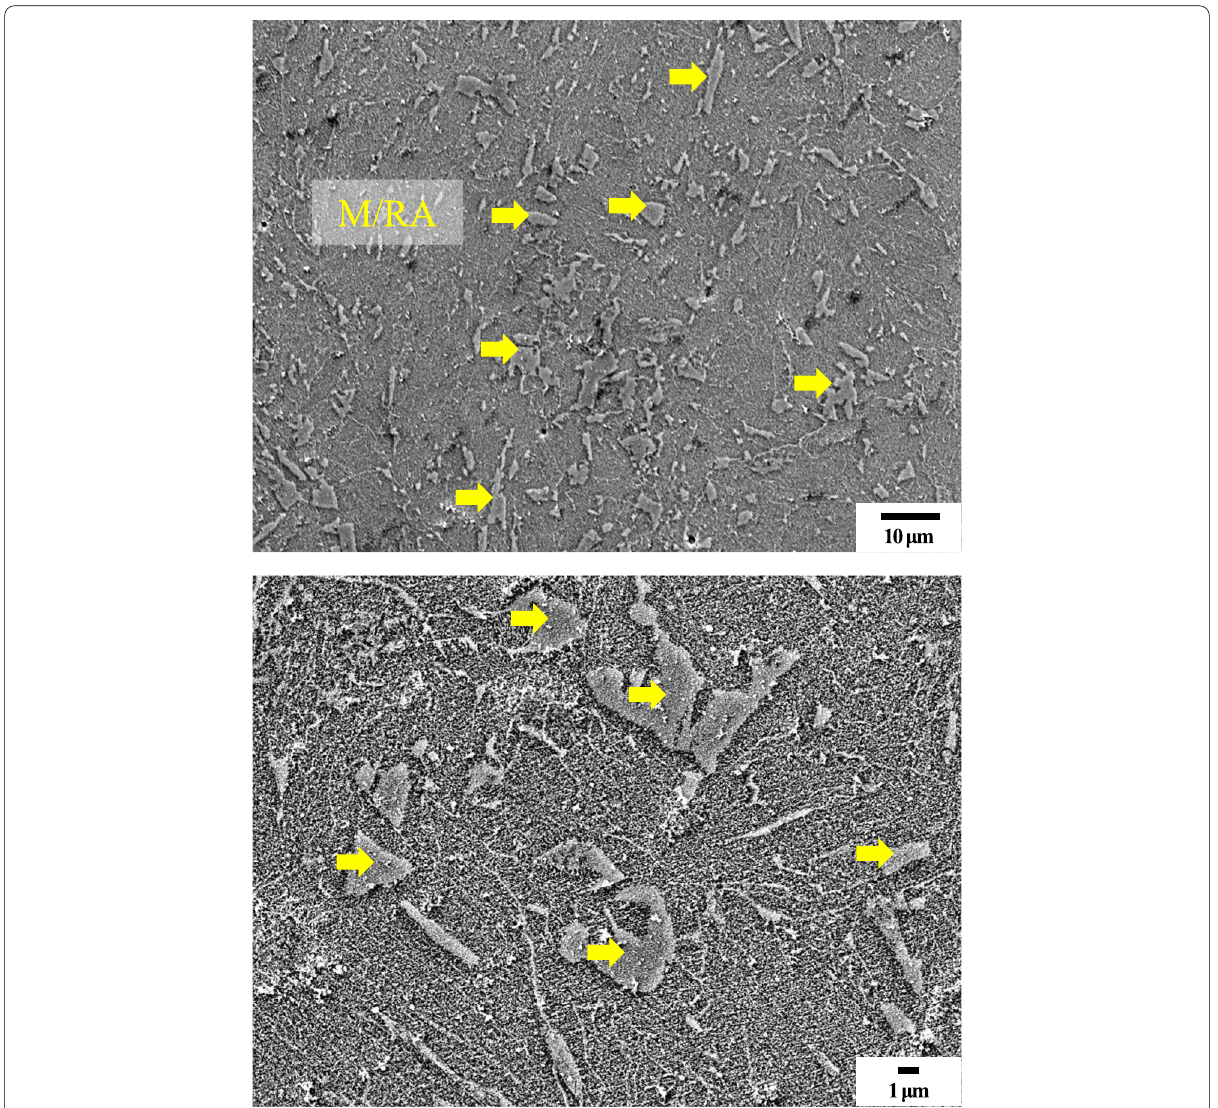
Fig. 9 Scanning electron micrographs subjected to Final LePera etching conditions of 4Nb specimen. Although it was possible to distinguish the M/RA phase, it is difficult to distinguish other